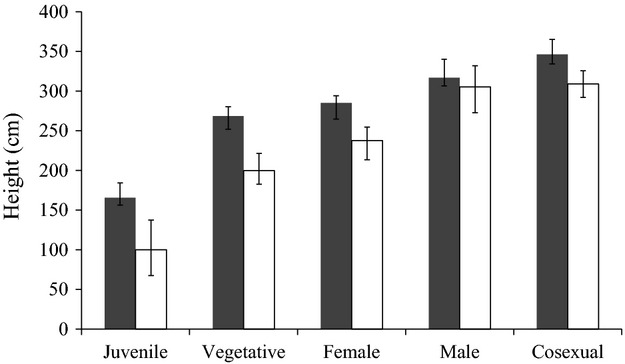
Effect of a single event of artificial selection for growth and timber yield on the height of the progeny from selected Pinus pinaster trees compared to an unselected control group. Bars represent average height at age 10 years for selected progenies (dark bars: n = 656) and the control, unselected group, representing the base population mean (white bars; n = 195). Results are presented for protogynous, protandrous and cosexual groups, as well as for vegetative–juvenile groups. Error bars represent 95% credible intervals. ‘Vegetative’ refers to those nonreproductive trees taller than the smallest reproductive tree for a given group.